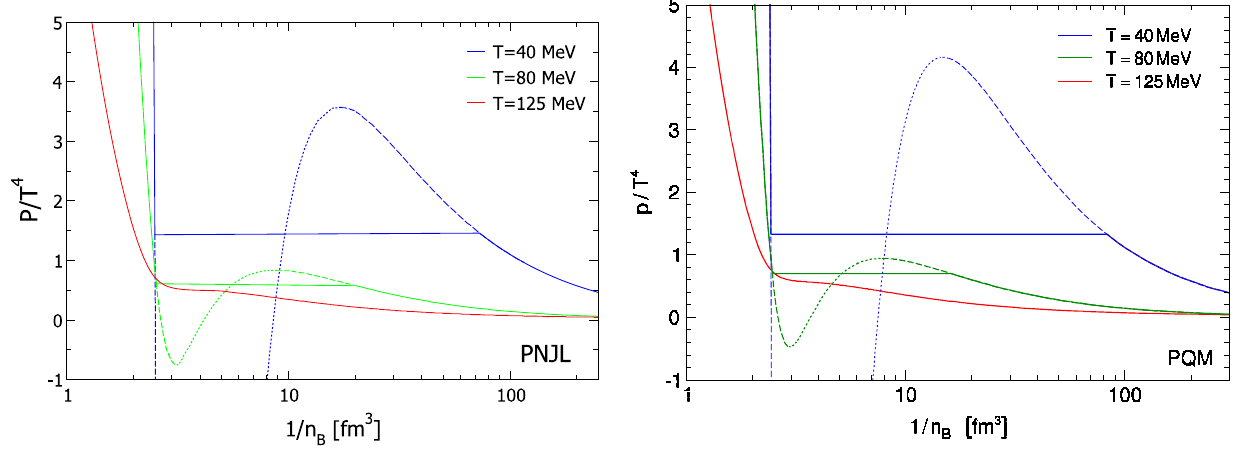
Fig. 5 Pressure vs specific volume for a few isothermal transforma- tions in the PNJL (left panel) and PQM (right panel) models. We plot curves both above and below the critical isothermal T CEP passing throughtheCEP.Inthecaseofafirst-ordertransitionwealsodisplaythe